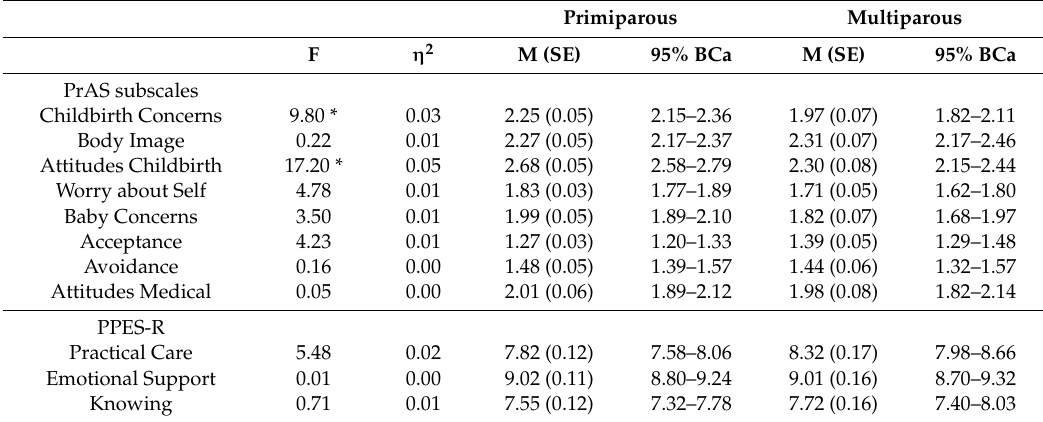
Table 8. Tests of between-subjects e ff ects for PrAS and PPES-R subscales and